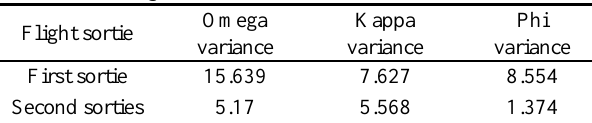
Table 1. Variance of Pose parameters for two